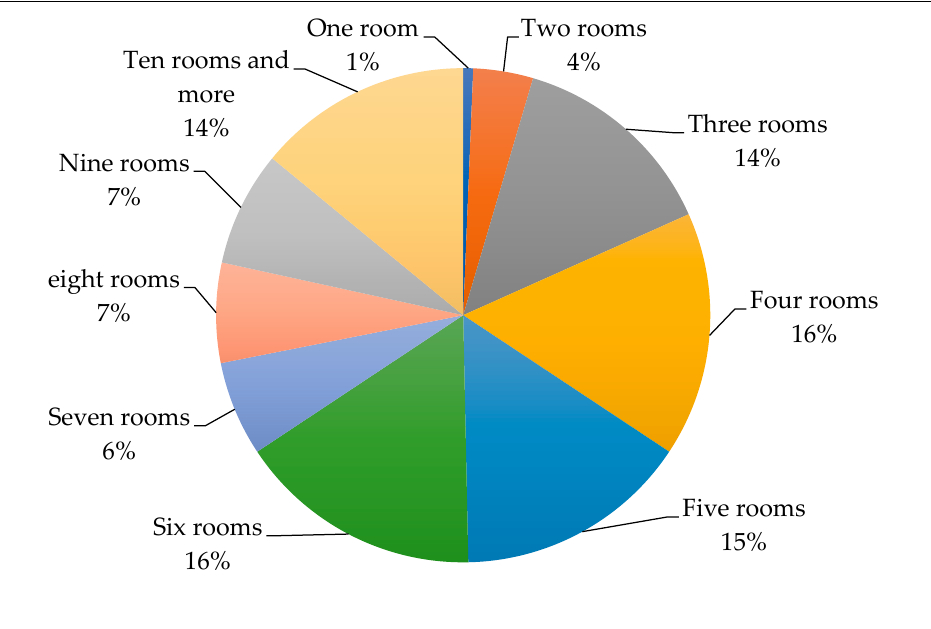
Figure 8. The number of rooms in each residential unit.